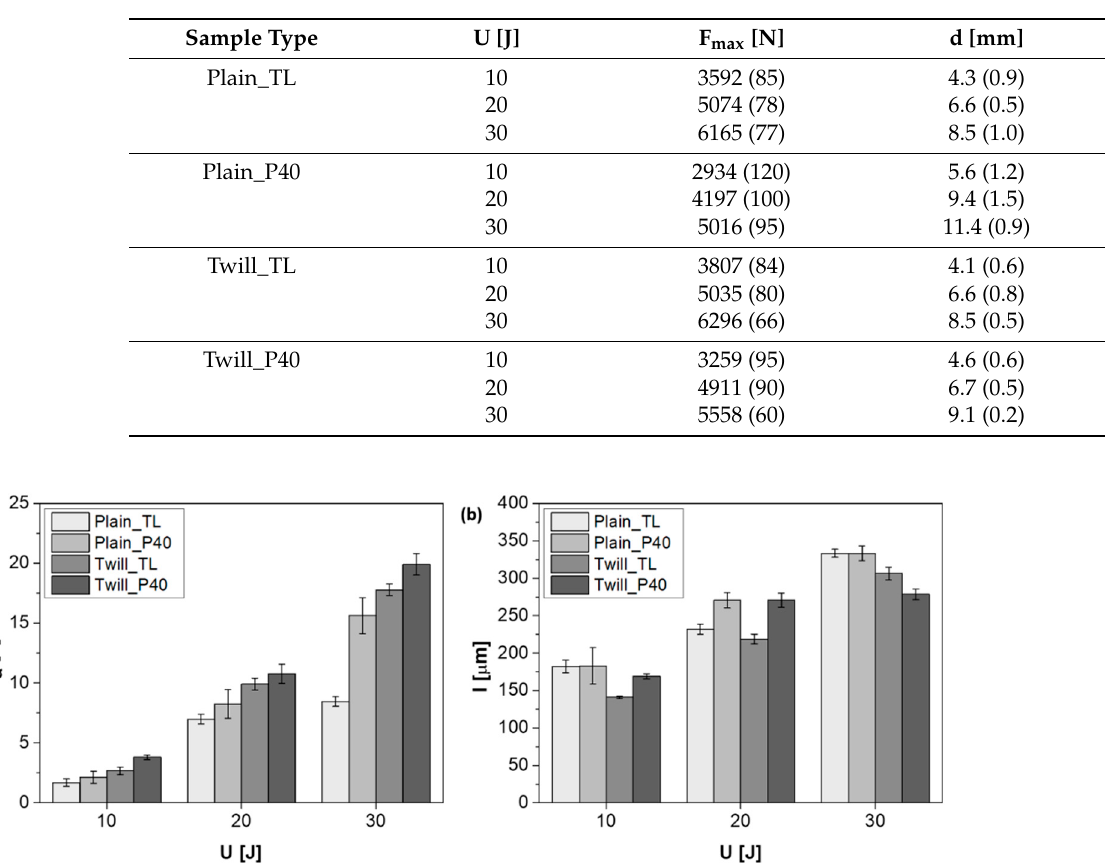
Figure 8. Absorbed energy ( a ) and indentation depth ( b ) as a function of the impact energy for all investigated materials.